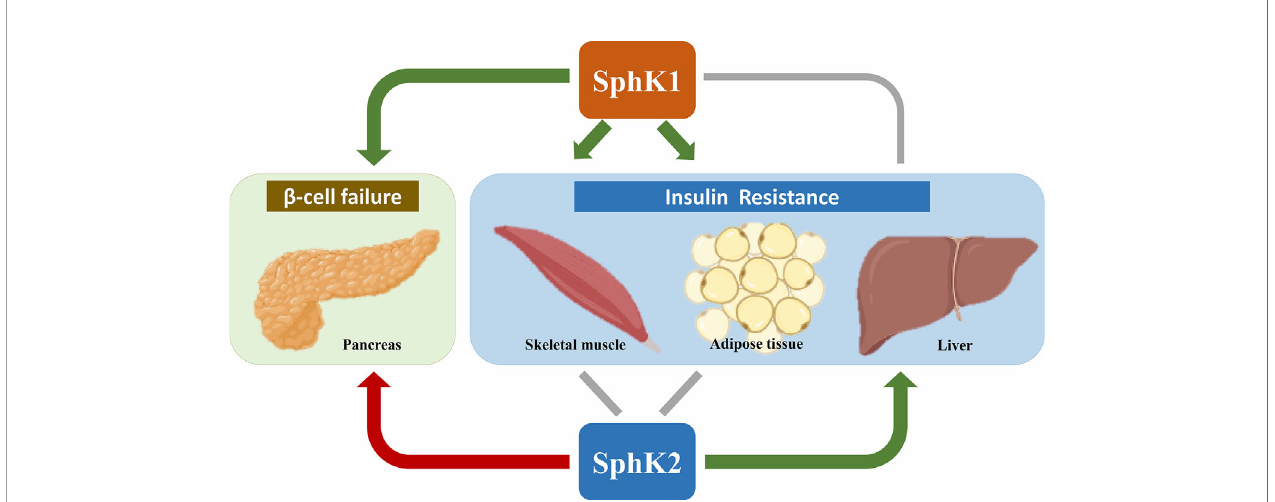
FIGURE 2 | Roles of SphK1 and SphK2 in T2D. Most of the literature supports an anti-diabetic role (denoted by green arrows) of SphK1 in skeletal muscle, adipose tissue and pancreas as well as SphK2 in the liver. In contrast, SphK2 is primarily a pro-diabetic factor (denoted by the red arrow) for its proapoptotic effects in pancreatic b -cells. The roles of SphK1 in the liver and SphK2 in skeletal muscle and adipose tissue are controversial (denoted by grey lines). Created in